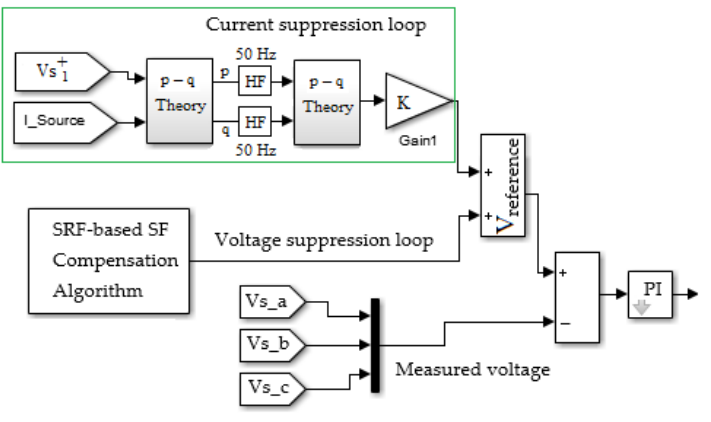
Figure 9. The proposed control algorithm for the SF.